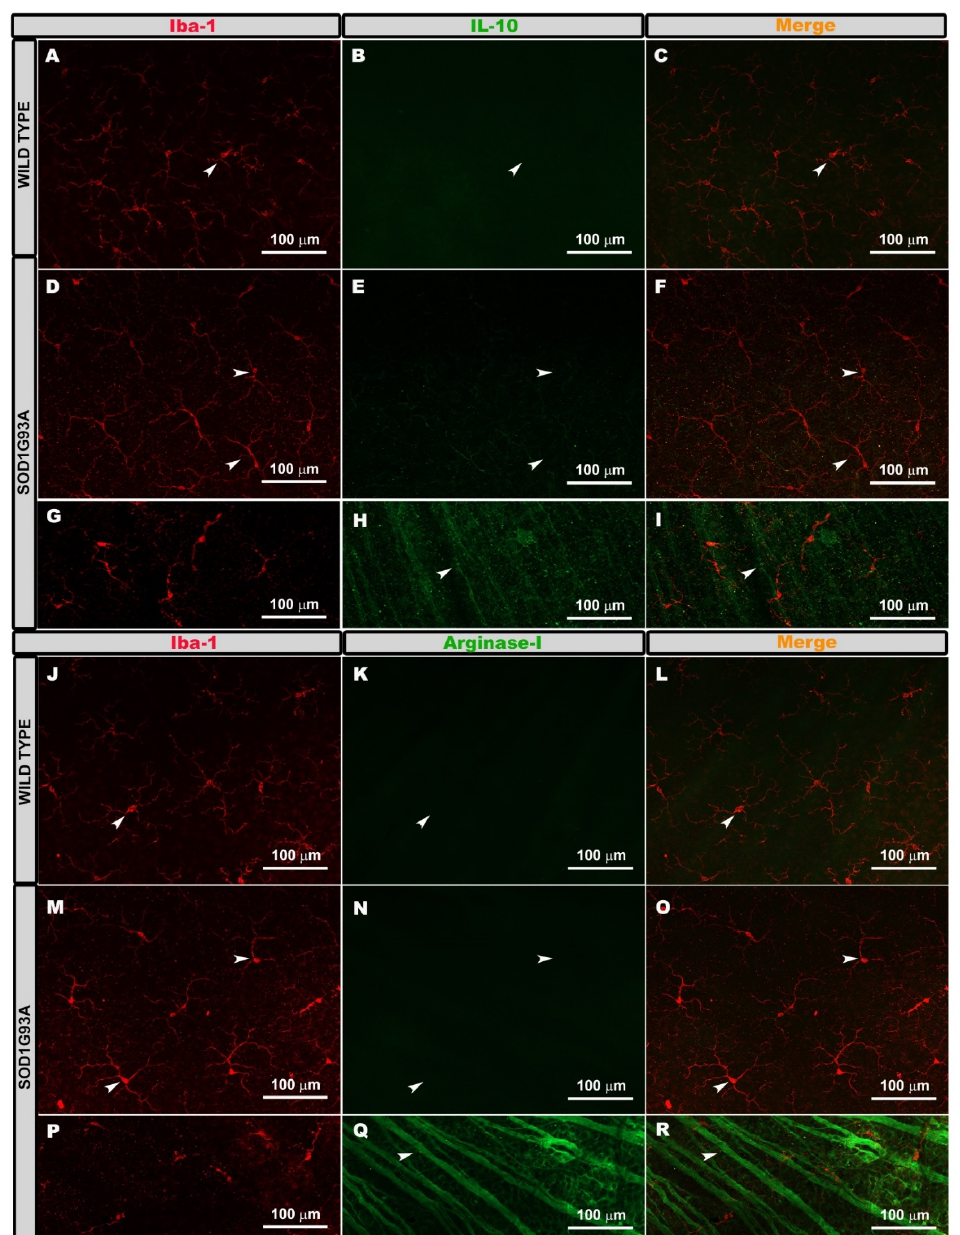
Figure 4. Anti-inflammatory M2 phenotype. Retinal whole-mounts labeled with anti Iba-1 and IL-10 ( A – F ) and with anti- iba-1 and arginase-I ( J – O ). Positive control for immunolabeling of IL-10 ( G – I ) and for arginase-I ( P – R ). The images ( A – O ) show the microglial plexus of the outer plexiform layer. The Iba-1+ cells were not labeled with IL-10 in either the wild type ( A – C ) or the SOD1G93A group ( D – F ) (arrows). They were also not labeled with arginase-I in the wild type group ( J – L ) or in the SOD1G93A group ( M – O ) (arrows). The axons of the retinal ganglion cells were labeled with IL-10 ( H , I ) (arrows) and with arginase-I ( Q , R ) (arrows). Number of retinas used in the experiment, WT: n = 3; and SOD1G93A: n = 3.